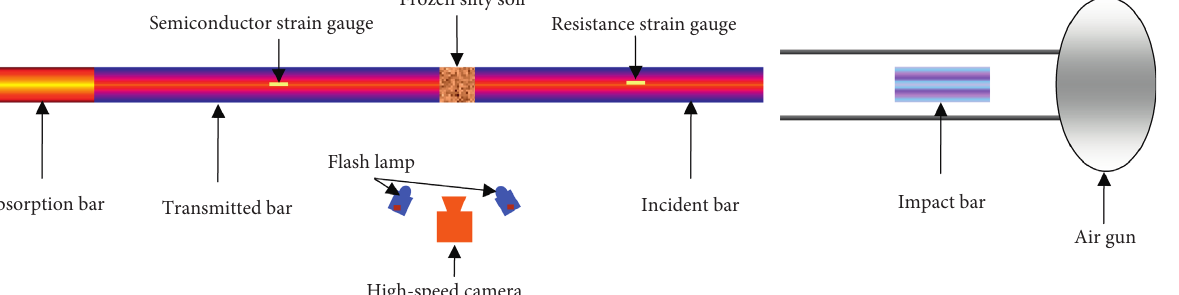
Figure 3: SHPB test system.